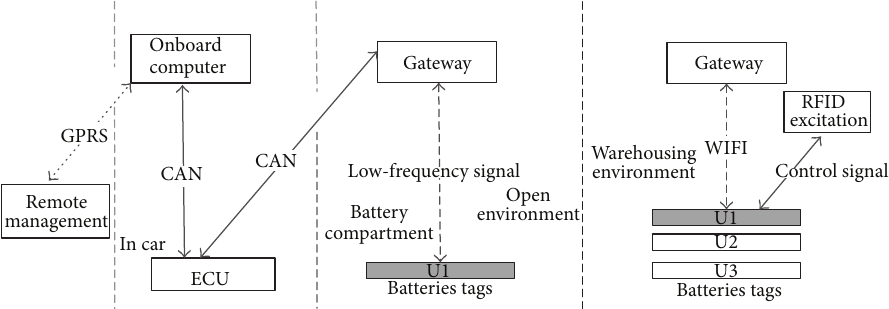
Figure 5: Design on RFID sensor application for battery